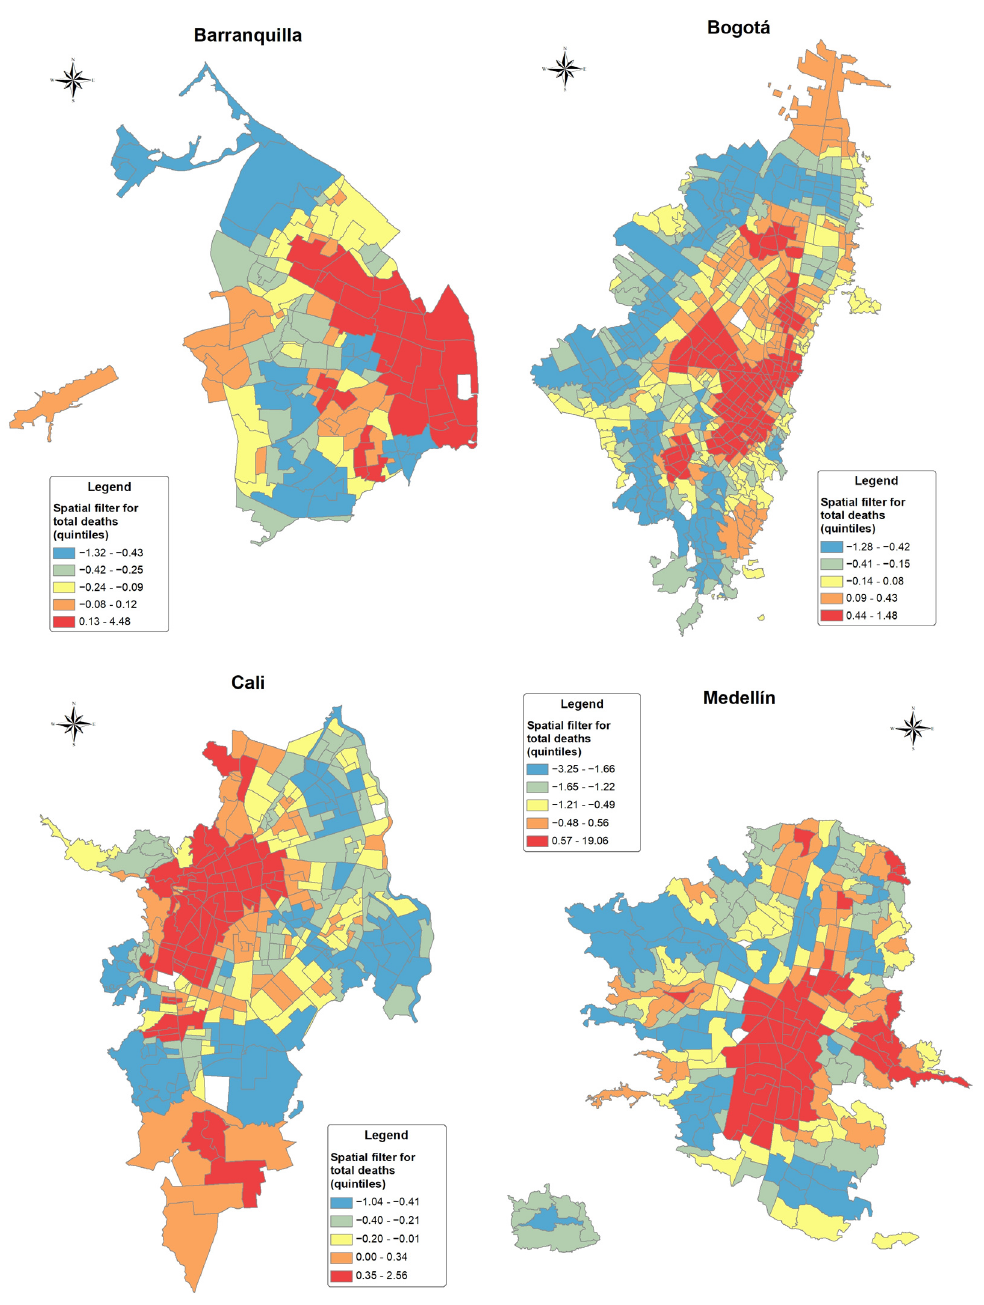
Figure 4. Moran eigenvector spatial filter for all deaths at census sector level by city in Colombia, 2015–2019. Note: Quintiles were split according to the spatial filter range values for each city.